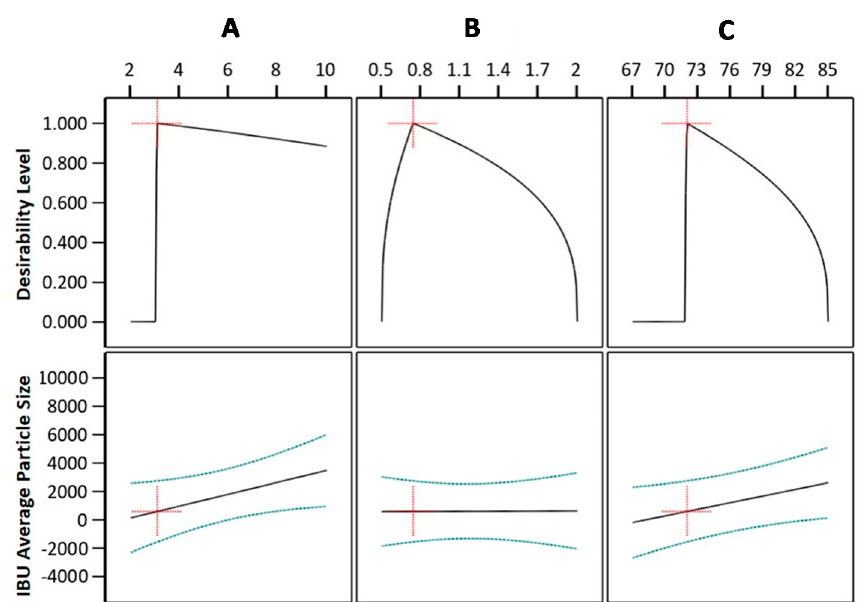
Figure 7. Desirability graphs of factors ( A ), ( B ) and ( C ), plotted against the IBU average particle size. The red crosses of the first row graphs correlate the achieved a desirability value of the y-axis against the x -axis predicted parameter value. The red crosses of the second row graphs correlate the first row values of desirability and each factor to the IBU average particle size CQA of 600 nm.